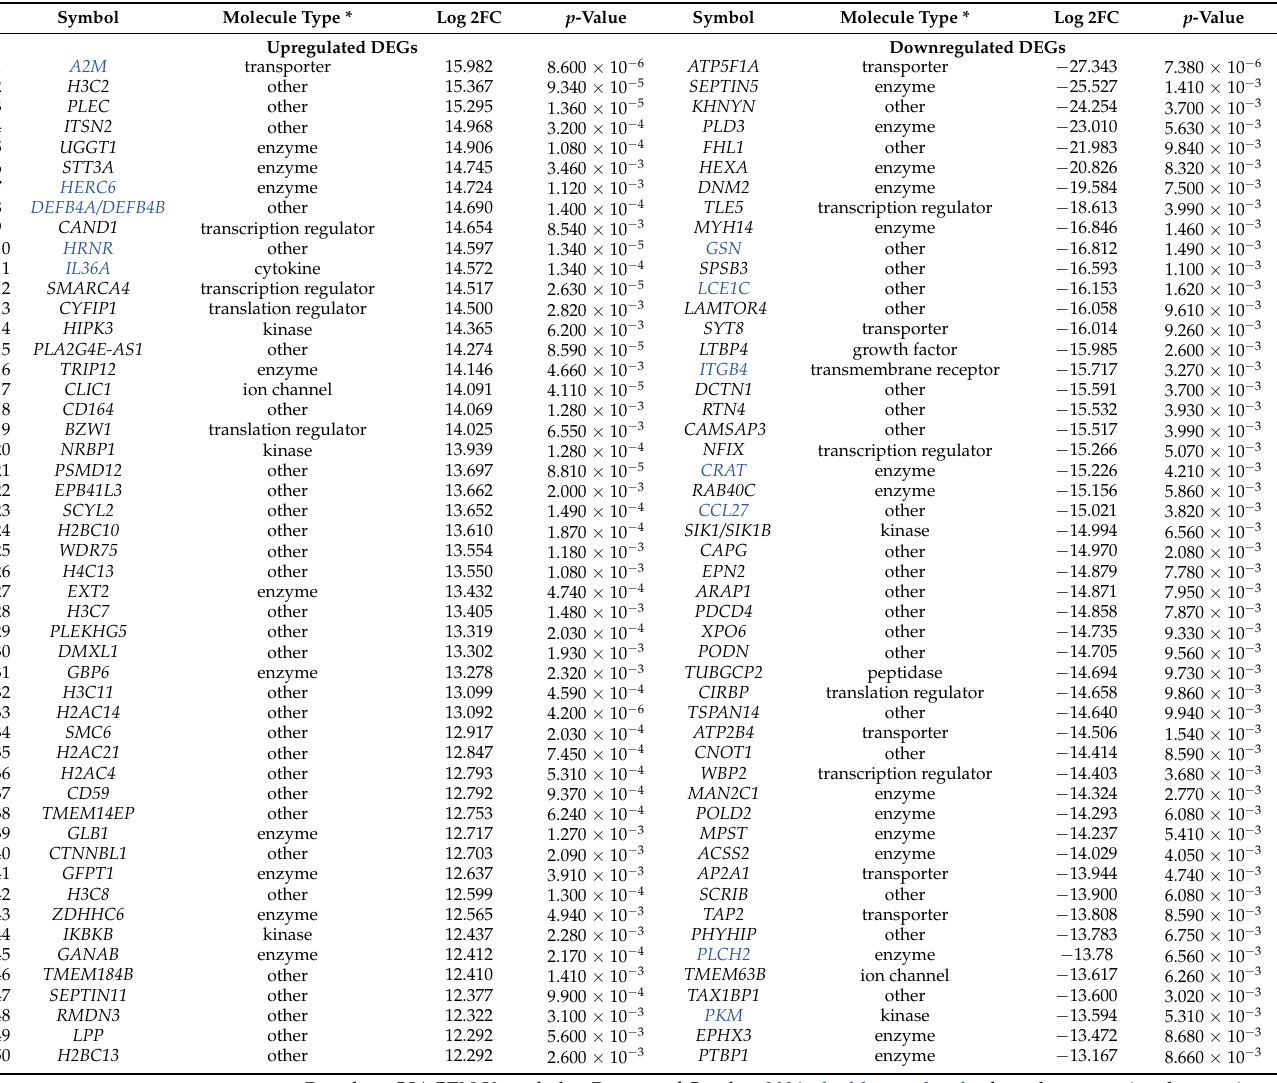
Table 1. The top-50 differentially expressed genes of peripheral edge of the lesional skin compared with uninvolved